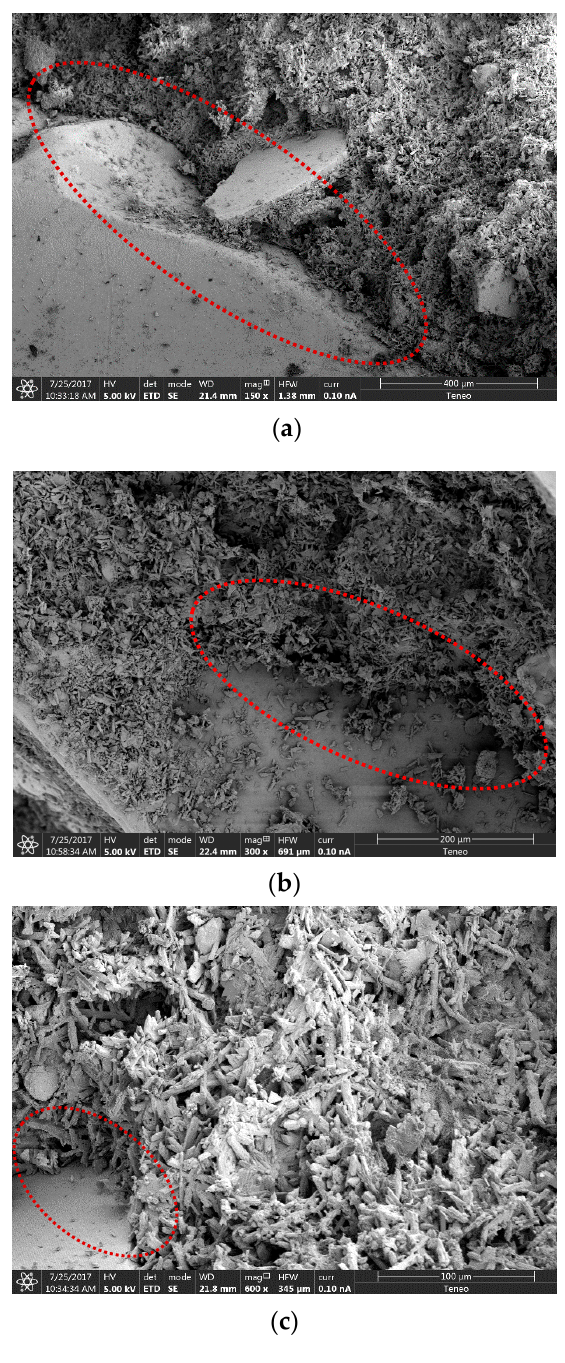
Figure 7. SEM images of the PC40 sample, showing a good adherence between the PC waste and the gypsum matrix: ( a ) 150×; ( b ) 300×; ( c )